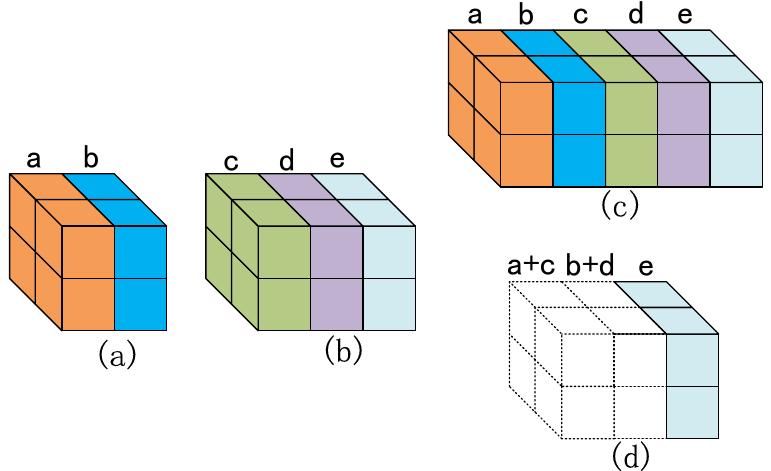
Figure 3. Operation of Add layer and Route layer; ( a ) A = [a,b]; ( b ) B = [c,d,e]; ( c ) C = [a,b,c,d,e]; ( d ) D = [a+c,b+d,e]; a, b, c, d are all feature maps; C is Route layer and D is Add layer.